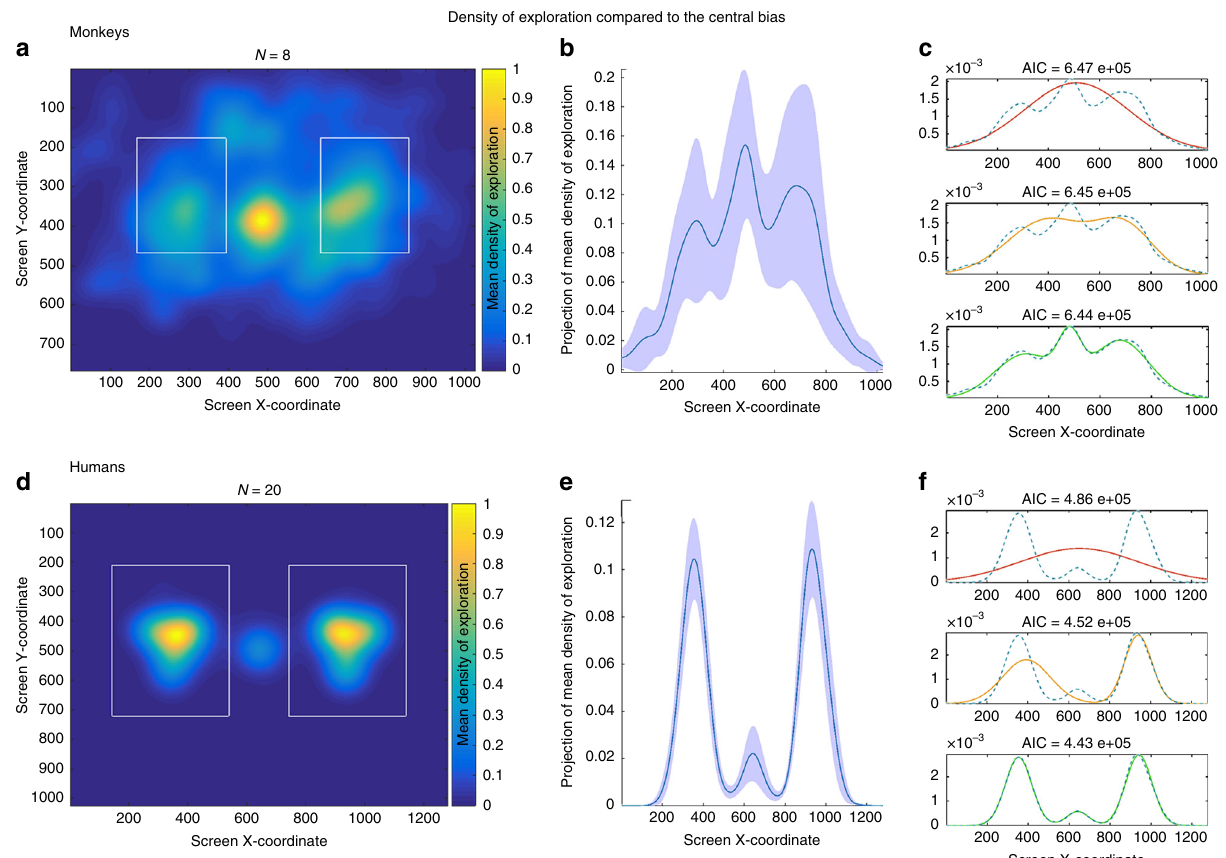
Fig. 1 Monkeys and humans density of exploration over the screen. Left upper and lower panel: Mean density of exploration in monkeys ( a ) and humans ( d ) over the whole screen (yellow-orange indicates high density exploration, dark blue low density exploration, rectangles indicate position of faces on the screen). Middle upper and lower panel: Projection of mean density of exploration on the x -axis of the screen in monkeys ( b ) and humans ( e ) (with 95% con fi dence interval). Right upper and lower panel: AIC value according to the central bias Gaussian model (red), two faces Gaussian model (yellow), two faces and central bias Gaussian model (green) in monkeys ( c ) and humans ( f